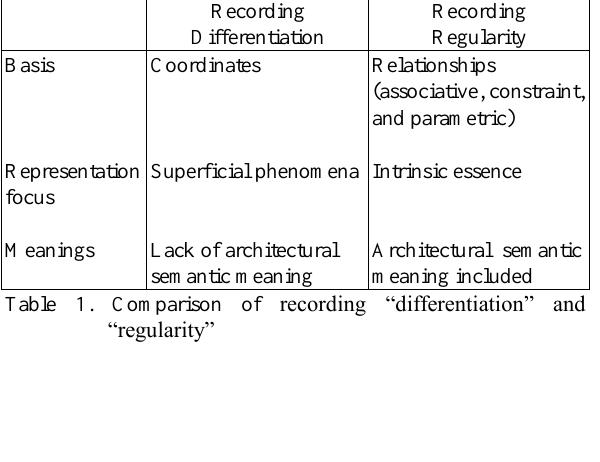
Table 1. Comparison of recording “differentiation” and